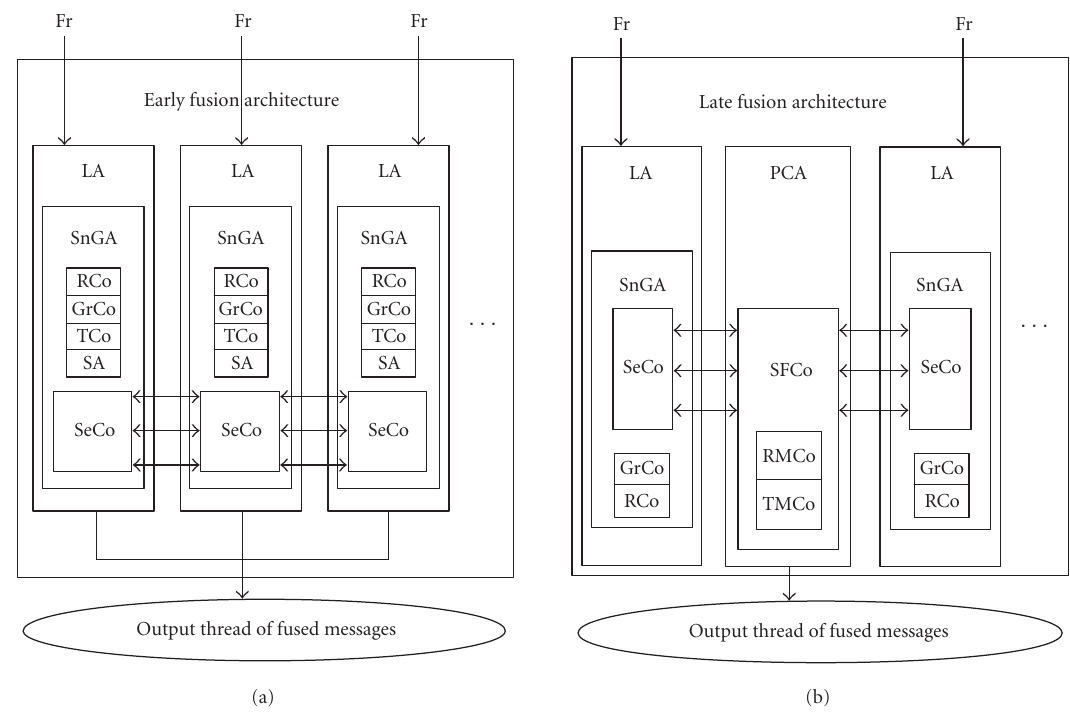
Figure 2: Principles of early and late fusion architectures (A: agent, C: control, Co: component, F: fusion, Fr: fragments of signal, G: generation, Gr: grammar, L: language, M: management, P: parallel, R: redundancy, S: semantic, Se: serialization, Sn: sentence, and T: time). More connections (arrows that indicate the data flow) could be added or removed by the agents to gather fusion